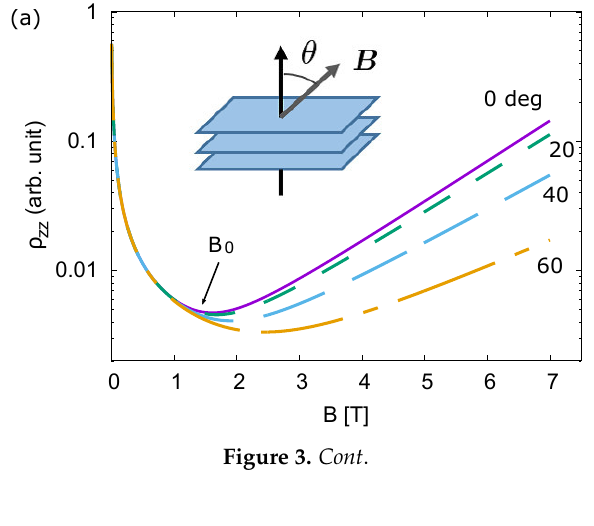
Figure 2. Numerical results on B -dependences of g ∗ ( a ) and E ∗ (solid line), 20 (dotted line), 40 (dashed line), and 60 ◦ (dot-dashed line). g and E Z in the absence of interaction are drawn by the thin solid line.